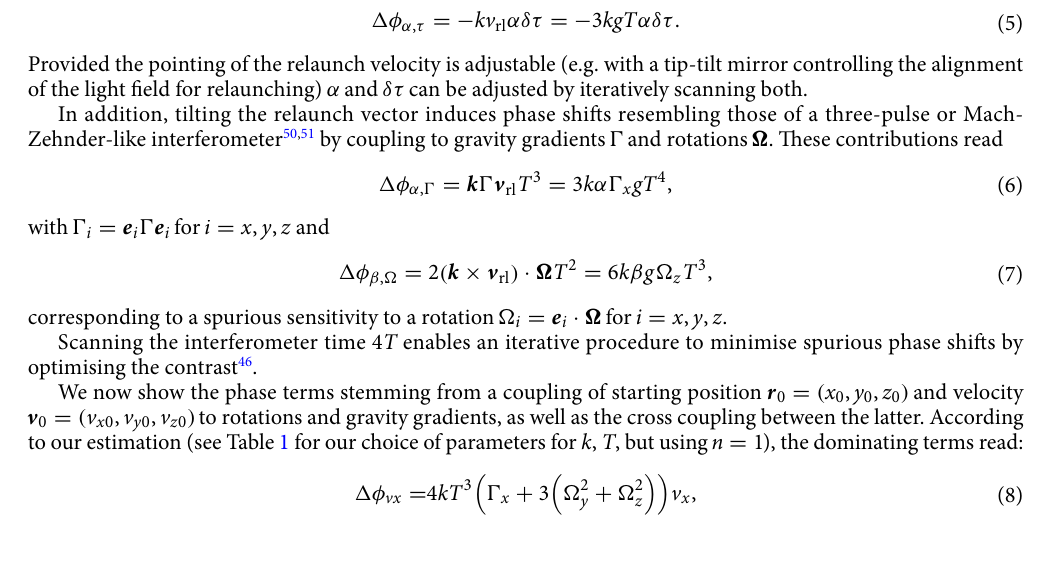
Spurious phase shifts